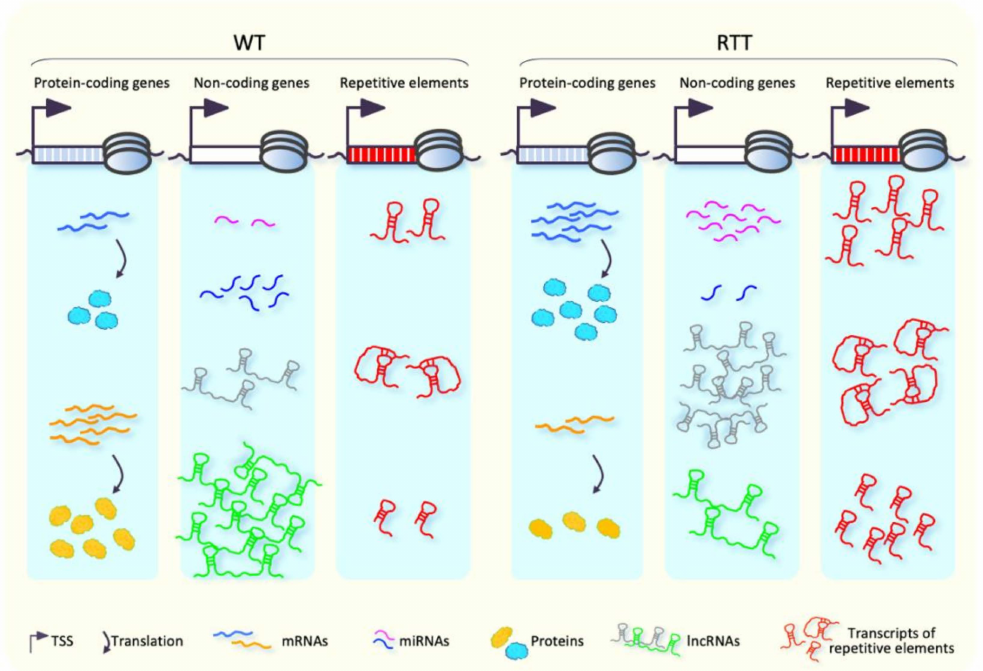
Figure 4. MeCP2 dysfunctions lead to a global alteration of the transcriptional program. ( Left panel ): In physiological conditions, both protein-coding and non-coding genes give rise to a variety of transcripts, some of which are expressed at high levels, whereas others are less abundant. Furthermore, the transcription rate of repetitive elements (including LINEs, intracisternal A particles and satellite DNA) is generally low. ( Right panel ): MeCP2 dysfunctions lead to the unbalanced production of both protein-coding and non-coding RNAs in both directions and to a general increased expression of repetitive